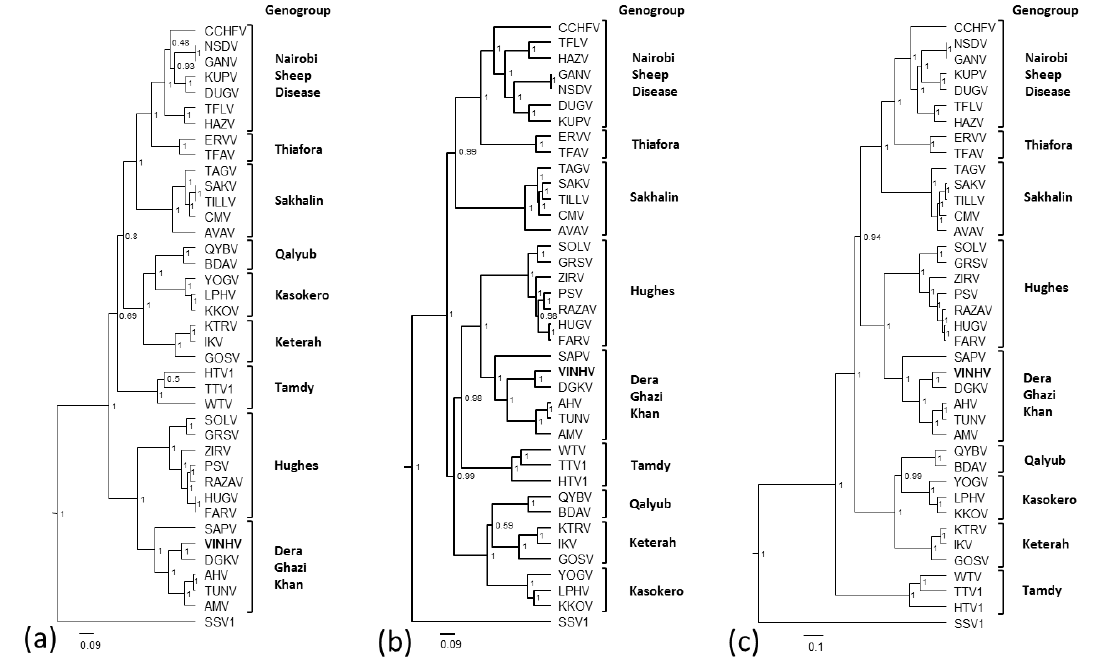
Figure 4. Phylogenetic analyses of the ( a ) nucleoprotein; ( b ) glycoprotein precursor, and ( c ) L protein of VINHV and other representative nairoviruses. Relationships were inferred by Bayesian analysis of the protein sequence alignments. A Whelan and Goldman (WAG) model of amino acid substitution with gamma + invariant site heterogeneity was used. Numbers represent Bayesian posterior probabilities. SSV1 was included as an outgroup. Trees are drawn to scale measured in substitutions per site as indicated by the scale bar.